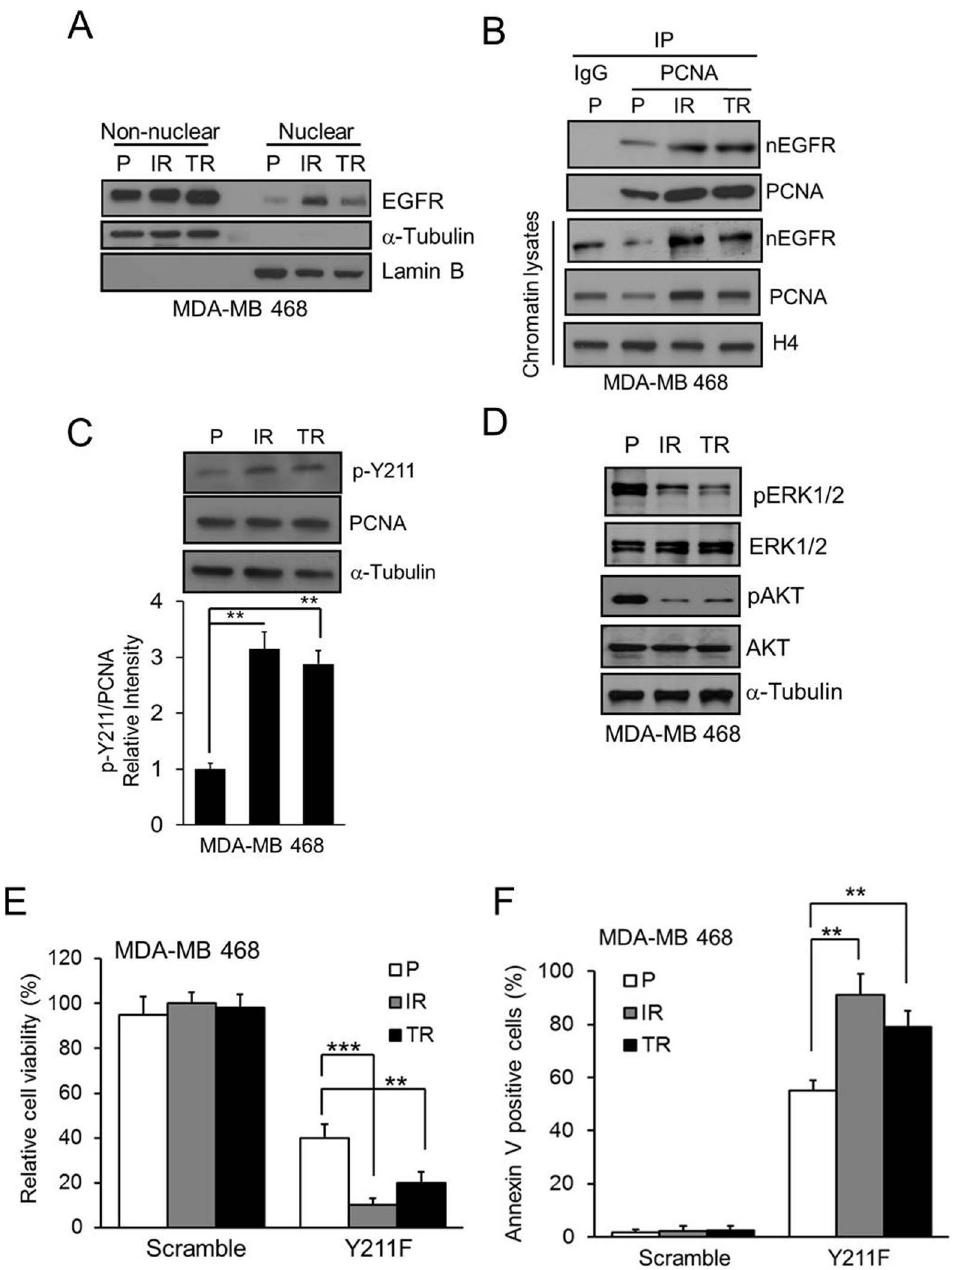
Figure 3. The cytotoxic effect of CPPP in TKI-resistant TNBC cells. (A) Cell lysate from non-nuclear and nuclear fractions were isolated from parental (P), Iressa-resistant (IR) or Tarceva-resistant (TR) MDA-MB 468 cells. The protein level of EGFR in each fraction was examined by IB. a -tubulin and lamin B were used as the markers of non-nuclear and nuclear fraction, respectively. (B) The association between nEGFR and PCNA in chromatin lysate from P-, IR- and TR-TNBC cells were verified by IP with IgG or anti-PCNA antibody. (C) The amount of p-Y211 on PCNA in each TNBC line was examined. A comparison of the relative intensity p-Y211 in IR- or TR-TNBC cells to the parental TNBCs is shown at the bottom. (D) Total cell lysate from P-, IR- and TR-TNBC cells were isolated. The protein level of indicated proteins were examined by IB. (E–F) The P-, IR-, or TR-TNBC cells were treated with 15 m M Y211F CPPP for 24 h and the relative cell viability (E) and Annexin V-positive cells (F) were determined. The bars indicate mean 6 S.D. **, p , 0.01; ***, p , 0.001 by t -test. doi:10.1371/journal.pone.0061362.g003 cells (Fig. 2C–2F). As drug resistance of cancer cells is one of the 468 (IR) and Tarceva-resistant MDA-MB 468 (TR). The results important reasons for therapeutic failure or cancer recurrence, we showed that the amounts of nEGFR (Fig. 3A), binding to PCNA asked whether the Y211F CPPP is also effective in the EGFR (Fig. 3B), stability of PCNA (Fig. 3B) and Y211 phosphorylated TKI-resistant TNBC cells. To this end, we established two more PCNA (Fig. 3C) were enhanced in both the IR and TR cells EGFR TKI-resistant TNBC cell lines: Iressa-resistant MDA-MB compared with the parental (P) cells. Importantly, IR and TR cells